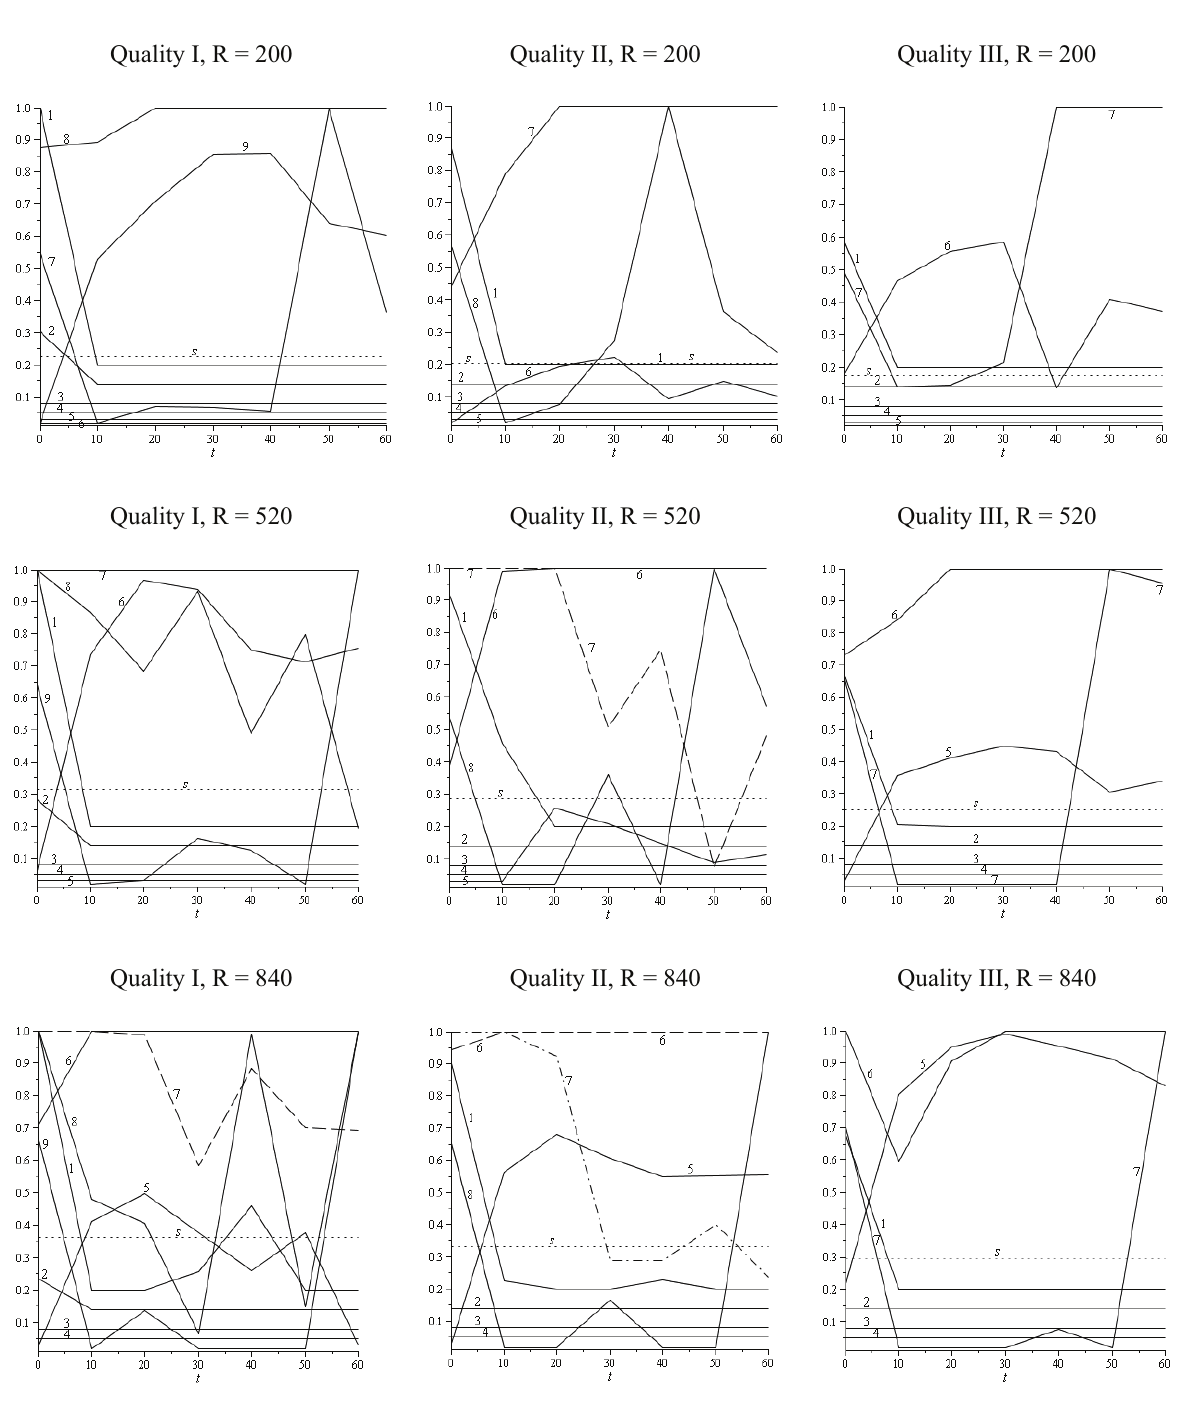
Figure 4. Optimal harvesting strategies, h Quality I; middle: Quality II; right: Quality III; first row: R = 200 stems/ha; second row: R = 520 stems/ha; third row: R = 840 stems/ha). The dashed lines depict the “sustainable/stable” harvest rates, s